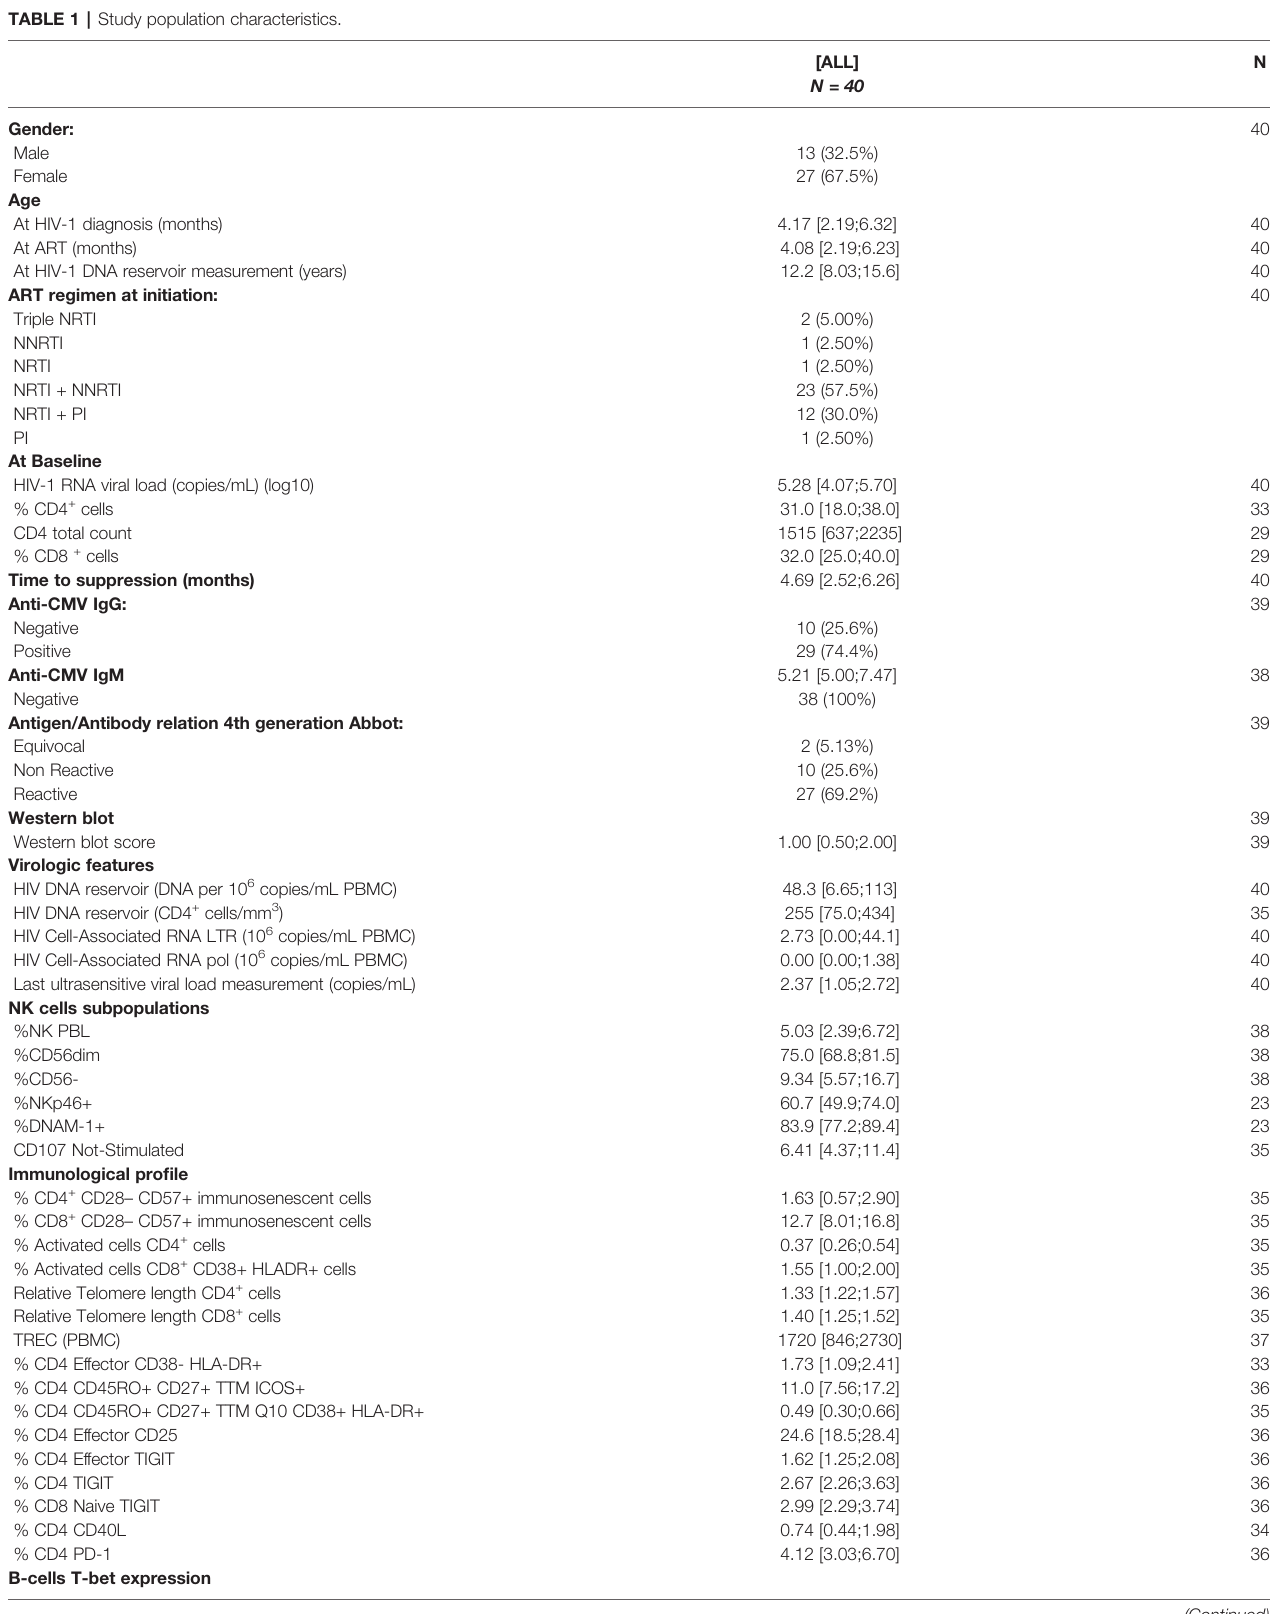
TABLE 1 | Study population